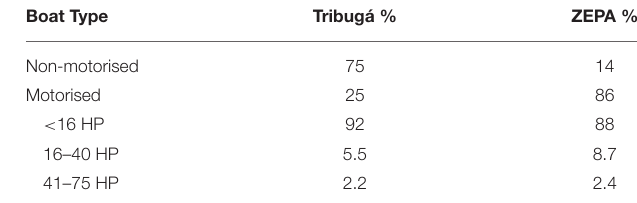
TABLE 2 | Proportion of fishing trips associated with different types of boats in the fisheries of the Exclusive Zone of Artisanal Fishing (ZEPA) and the Gulf of Tribugá between 2010 and